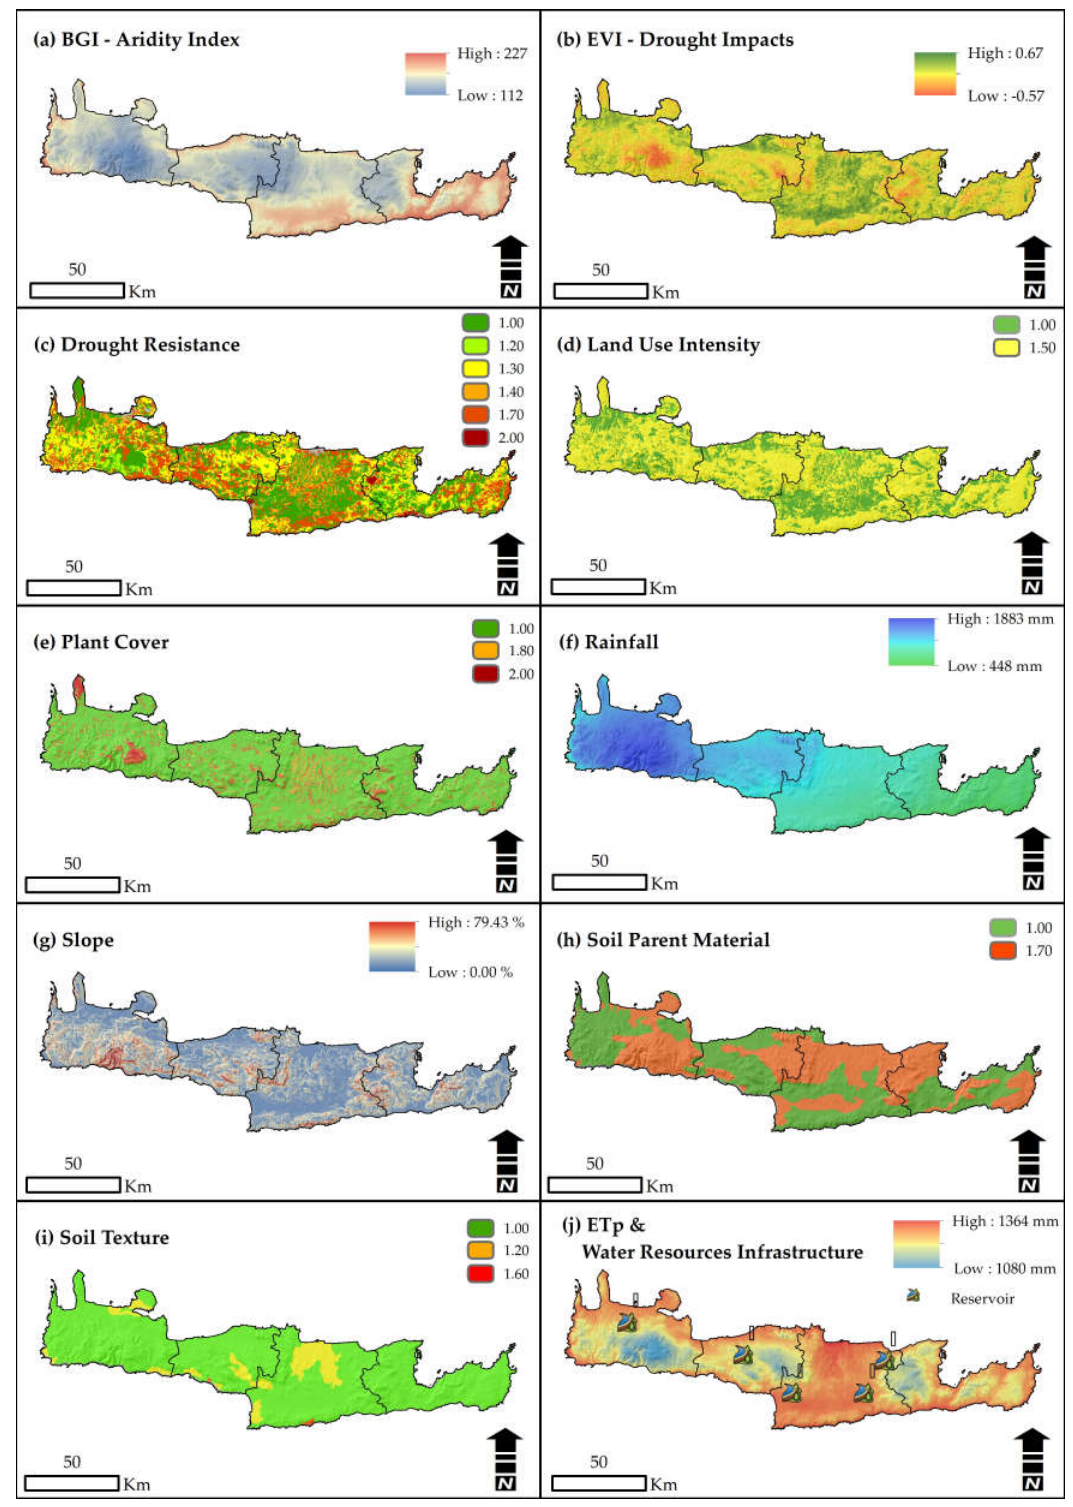
Figure 2. The inputs and indicators for the calculation of WLDI. ( a ) BGI Aridity Index, ( b ) EVI— Vegetation Drought Impacts, ( c ) Vegetation Drought Resilience, ( d ) Land Use Intensity, ( e ) Plant Cover, ( f ) Rainfall, ( g ) Slope, ( h ) Soil Parent Material, ( i ) Soil texture and ( j ) ETp and Water Resources Infrastructure.